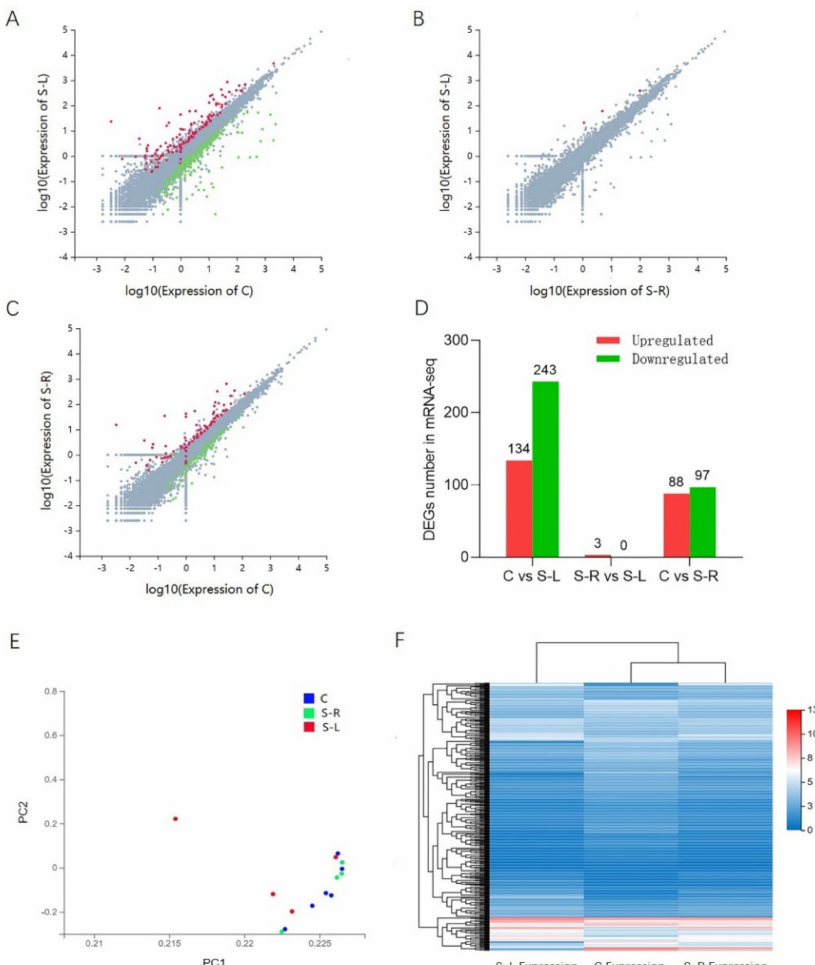
Figure 4. DEGs among 3 groups of gastrocnemius tissues. ( A – C ) Scatter plots of mRNA expression distribution between S − L group and C group, or between S − L group and S − R group, or between S − L group and C group. Color: Blue indicates downregulated genes, red indicates upregulated genes, and gray indicates nondifferentially expressed genes. ( D ) Quantity statistics of DEGs, in which the red column represents upregulated DEGs and the green represents downregulated DEGs. ( E ) Principal component analysis of differentially expressed genes among 3 groups. ( F ) Heatmap of differentially expressed genes (DEGs) among 3 groups, in which rows represent genes, and columns represent different